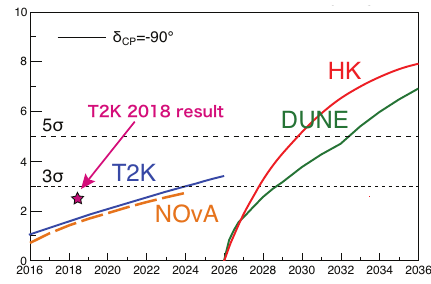
Fig 3. There is a small ripple in the neutrino flux as a function of L / E that depends on the mass